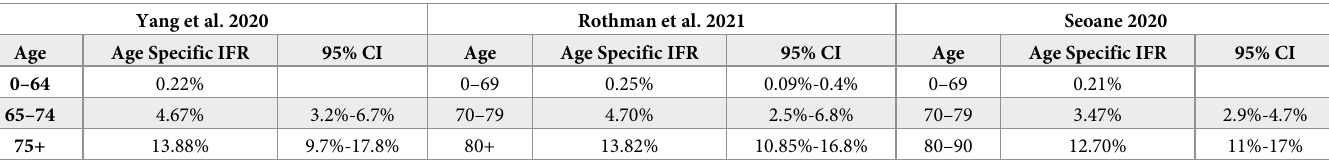
Table 4. Comparison of age specific IFR coefficients from the present study with serological testing studies internationally [44] and a comprehensive analysis of results from NYC [25] To facilitate comparison, we calculated a 0–64 group mean value for Yang et al. [25] and a 0–69 mean value for Seoane [44] by averaging their reported age sub group IFR values and weighting by percentage of each subgroup of the total infected